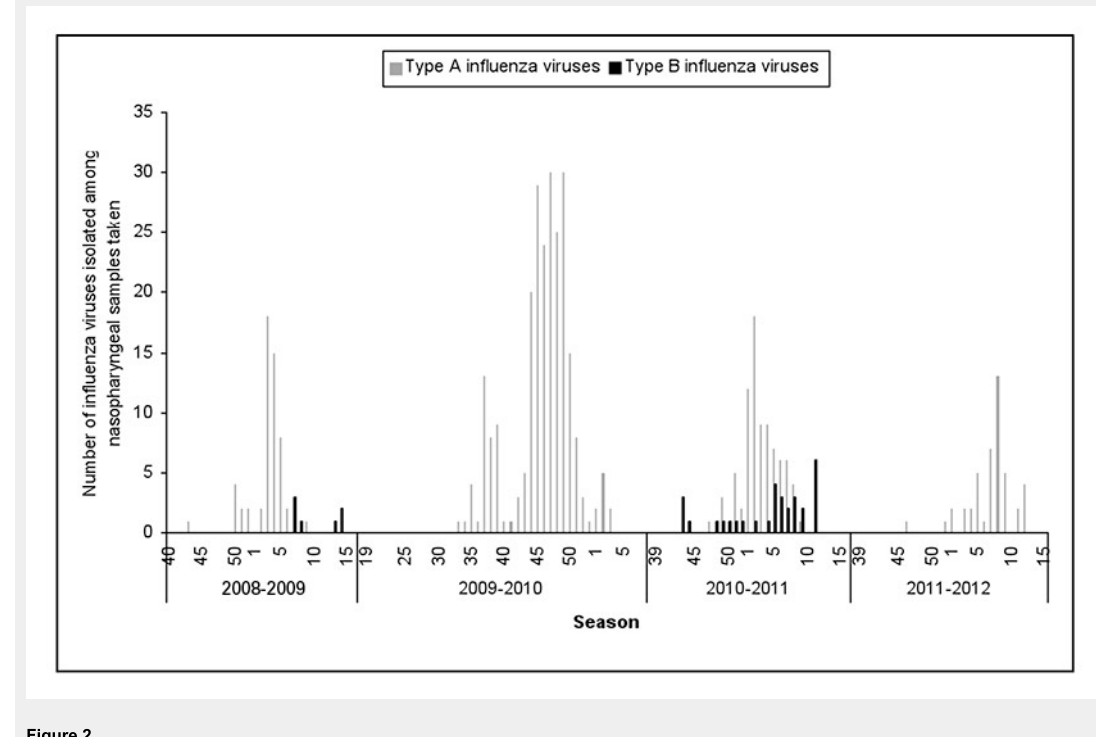
Figure 2 Number of type A and B influenza viruses isolated by MISS network – influenza seasons 2008‒2009 to